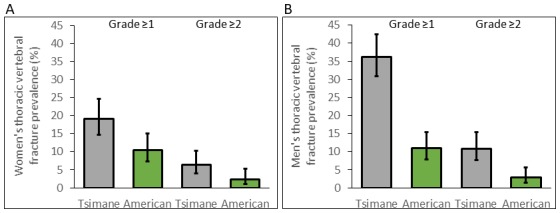
Thoracic vertebral (T6–T12) fracture prevalence (95% CIs) for Tsimane (in gray) and American (in green) women (A) and men (B) by fracture grade.Prevalence based on a less (grade ≥1) and more (grade ≥2) conservative fracture definition is shown. Prevalence is estimated from log-binomial generalized linear models adjusting for age.